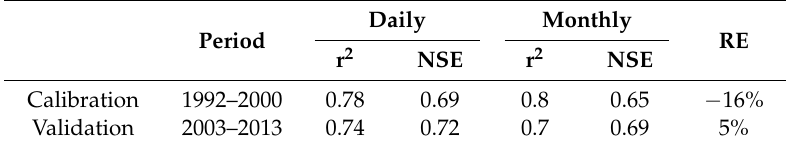
Table 5. Calibration and validation statistics for modelled baseline runoff in the Yongding river basin. Daily Period